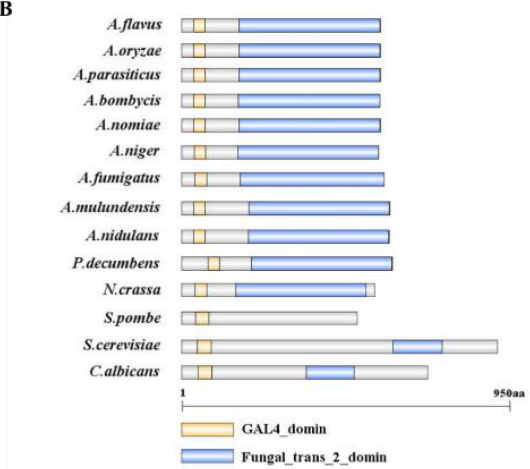
Figure 1. Summary of SfgA from different fungi. ( A ) A phylogenetic tree of the SfgA homologs identified in different species including A. flavus NRRL3357 (AFLA_005520). The tree was generated using MEGA 7 software with neighbor-joining and bootstrap method. ( B ) Domain analysis of the SfgA homologs in species. Protein structure was characterized using SMART and drawn using DOG 2.0 software.